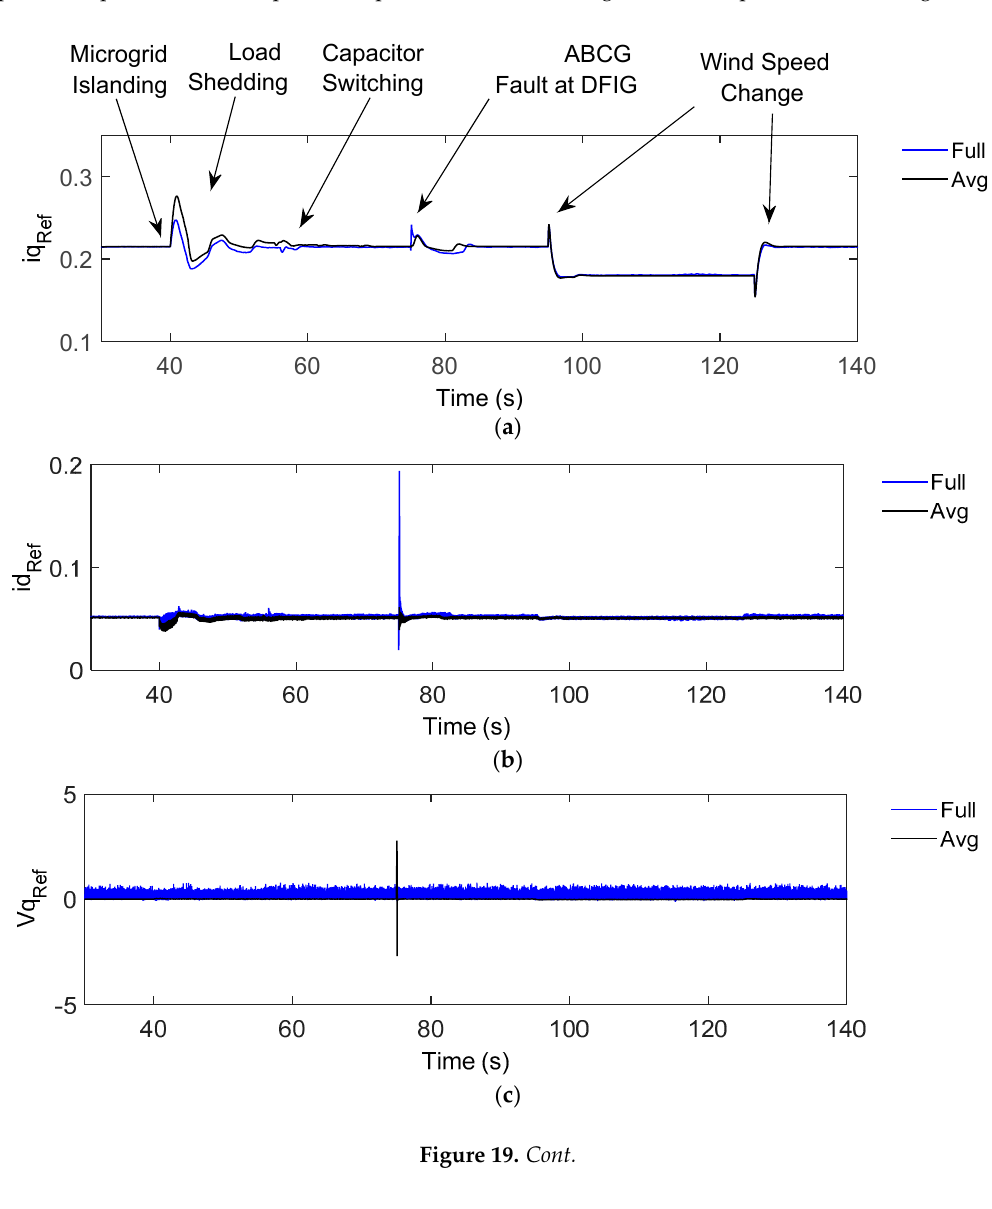
Figure 18. Outputs when the microgrid is islanded and followed by different transients: ( a ) active power outputs, ( b ) reactive power outputs, ( c ) load bus voltage, ( d ) DFIG speed, ( e ) DC voltage.